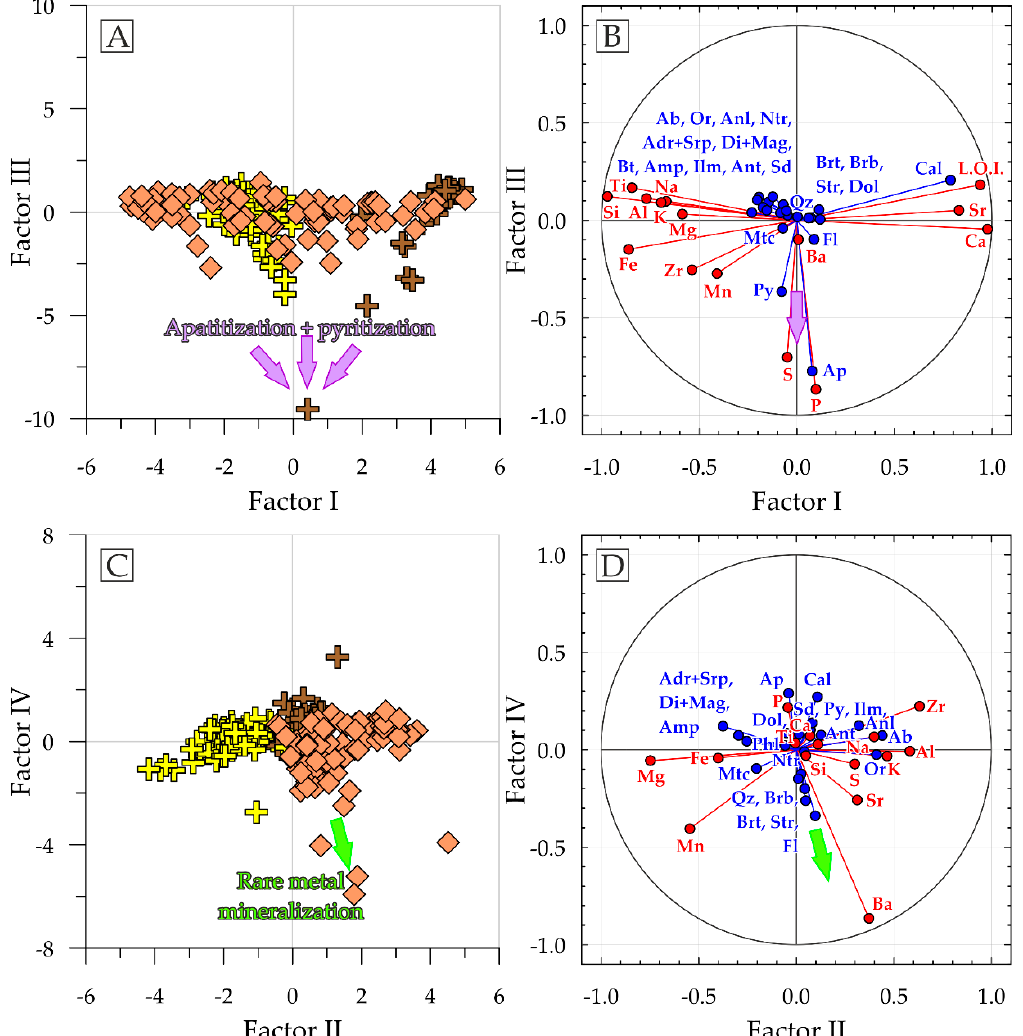
Figure 8. Projection of the ( A ) cases and ( B ) variables onto the factor-plane in the “Factor I–Factor III” coordinates. Projection of the ( C ) cases and ( D ) variables onto the factor-plane in the “Factor II–Factor IV” coordinates. The legend is the same as in Figure 7.